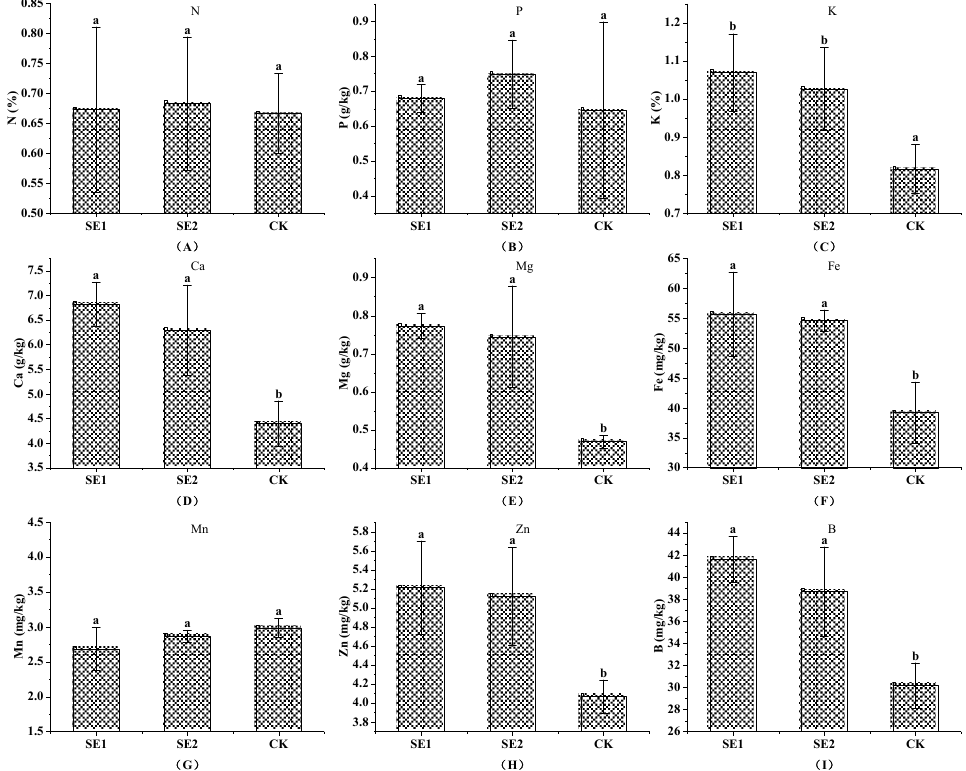
Figure 1. Effects of organic fertilizer on the levels of mineral elements ( A ) nitrogen, ( B ) phosphorus, ( C ) potassium, ( D ) calcium, ( E ) magnesium, ( F ) iron, ( G ) manganese, ( H ) zinc, and ( I ) boron in ‘Fuji’ apples. Different lowercase letters indicate significant differences between treatments ( p < 0.05).